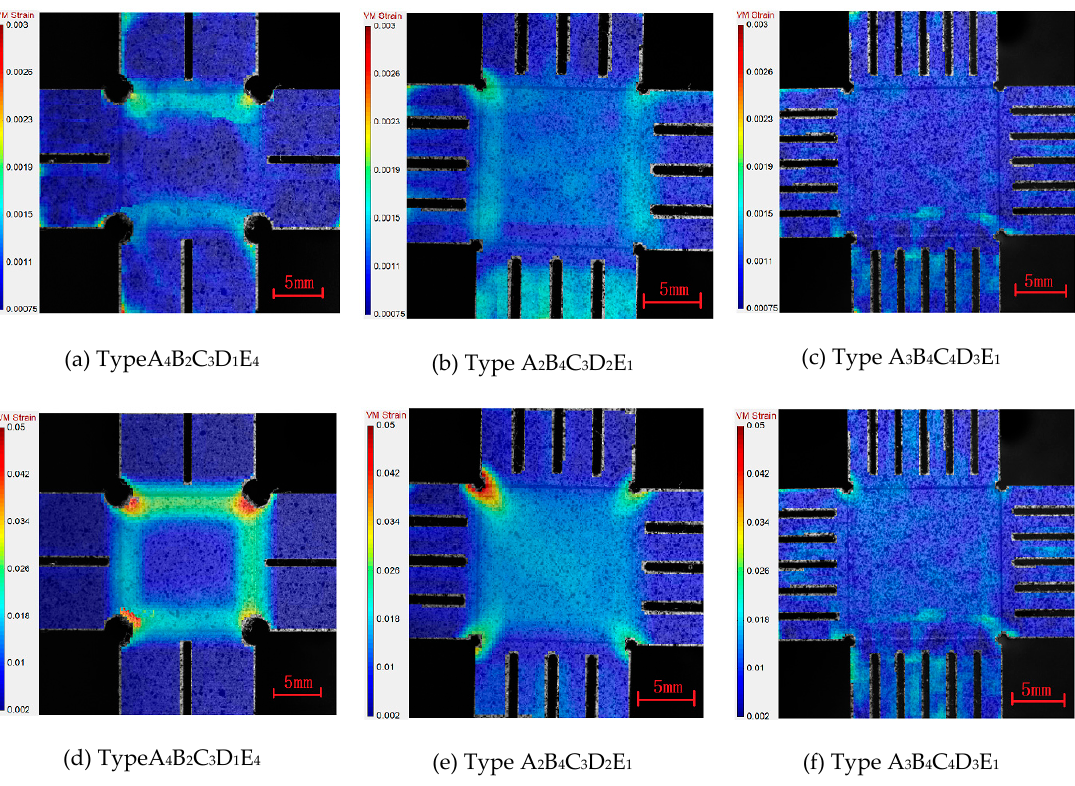
Figure 16. The full-field strain distributions obtained using DIC technology of the specimens with various types: ( a – c ) σ (cid:2868) = 100 MPa , n = 1, ( d – f ) σ (cid:2868) = 310 MPa , n = 1.